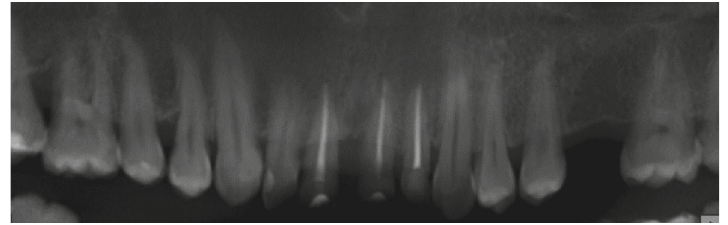
Figure 10: No pathology and resorption. 3-year radiograph